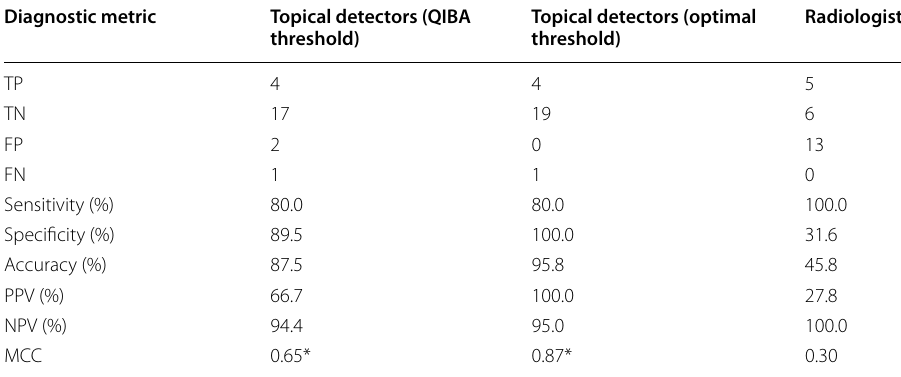
*Significantly different from the radiologist metric based on the jackknife estimate of standard error and Student’s t- test